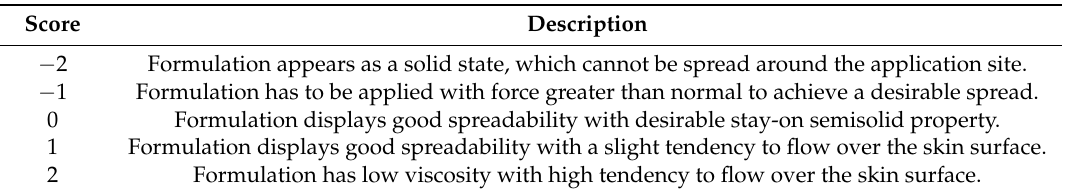
Table 3. Criteria used to assess the spreadability of